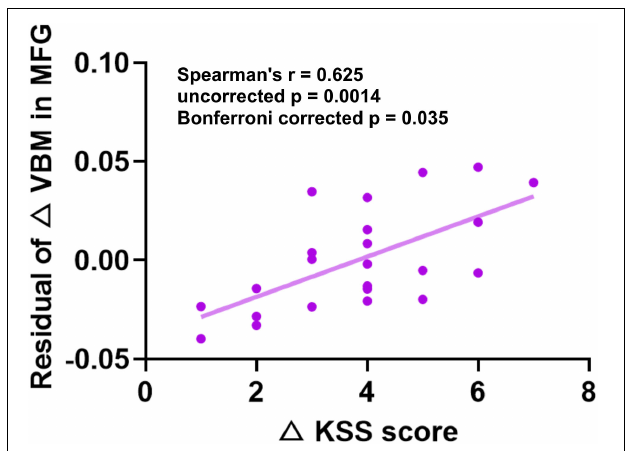
FIGURE 4 | Significant positive Spearman’s correlations between GMD changes in MFG and KSS changes. KSS, Karolinska Sleepiness Scale; GMD, gray matter density; MFG, middle frontal